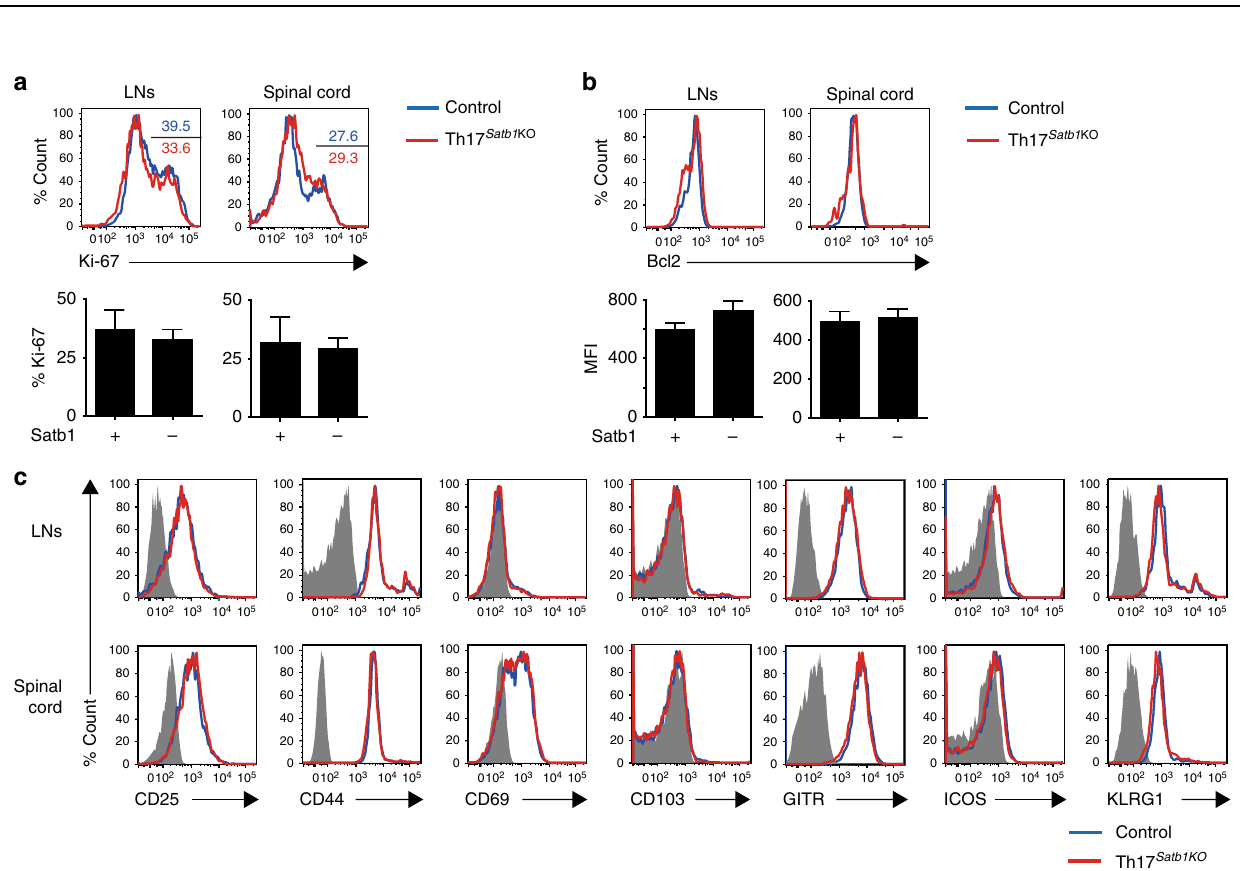
The mean (±s.d.) maximal clinical scores and mean (±s.d.) day of onset after EAE was induced in Il17a Cre R26R eYFP Satb1 wt/wt (control) ( n = 8) and Il17a Cre R26R eYFP Satb1 fl / fl (Th17 Satb1 KO ) mice ( n = 7) as in Fig. 2a